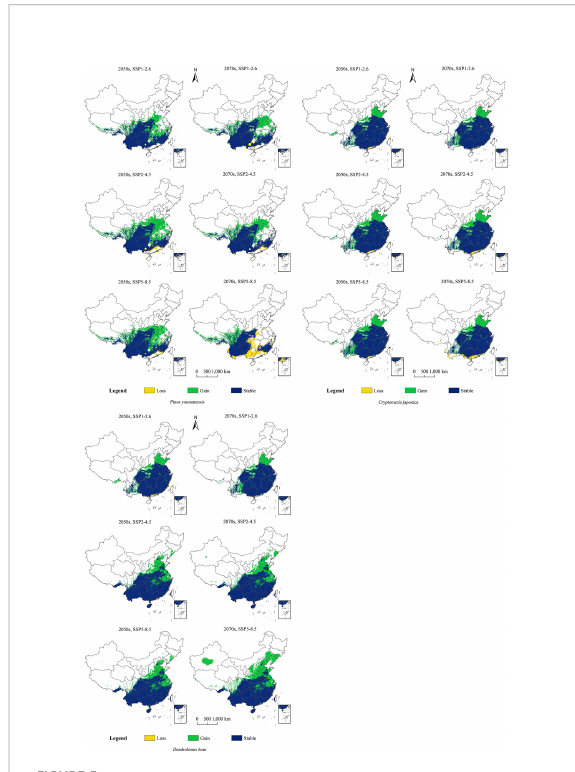
FIGURE 5 Changes in the potential geographical distributions of P. yunnanensis , C. fortunei , and D. houi under different climate- change